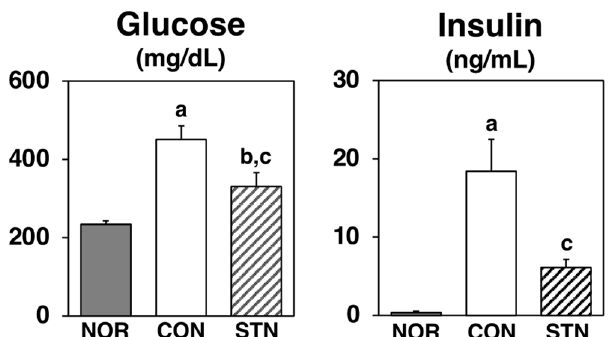
Figure 2. Glucose and insulin levels in the serum of C57BL/6J and db / db mice fed experimental diets for 4 weeks. Values are expressed as the mean ± standard error ( n = 5). a Significant difference at p < 0.05 between NOR and CON; b significant differences at p < 0.05 between NOR and STN; c significant differences at p < 0.05 between CON and STN.